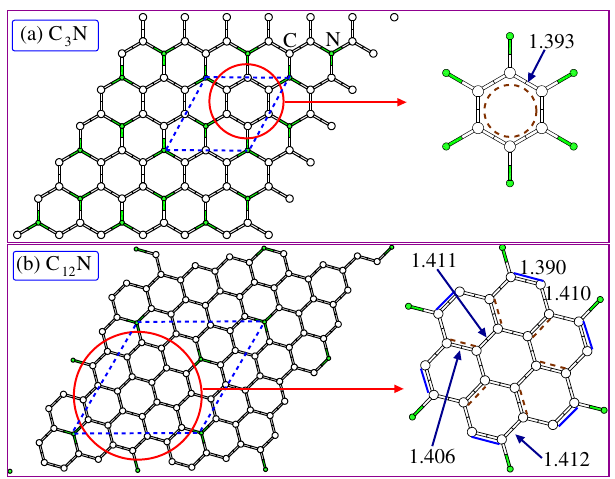
FIG. 2. (a) The ordered N-doped graphene superstructure for N . (b) The ordered N-doped graphene superstructure for C 3 N . A unit cell of the each superstructure is enclosed by C 12 dashed lines. Each right panel displays the enlarged view of the structure that is enclosed by a red circle in the left panels. The numbers denote the bond lengths (in A˚ ). The Clar formulas are specified by the circle, solid, and dashed